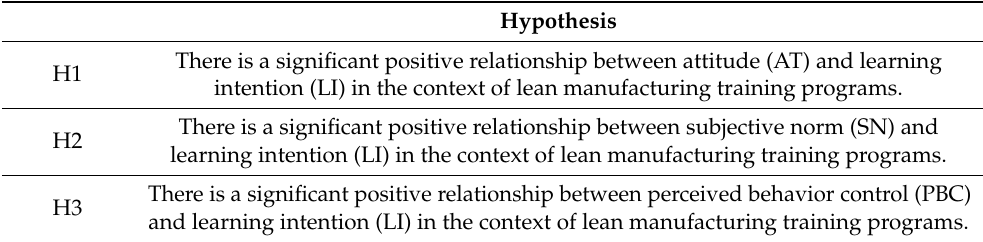
Table 1. A summary of the hypotheses for the